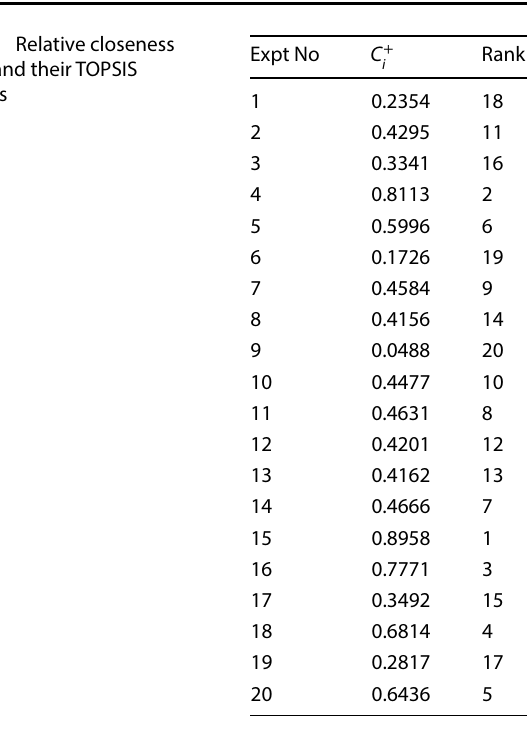
Table 10 Separation measures for positive and negative ideal solutions